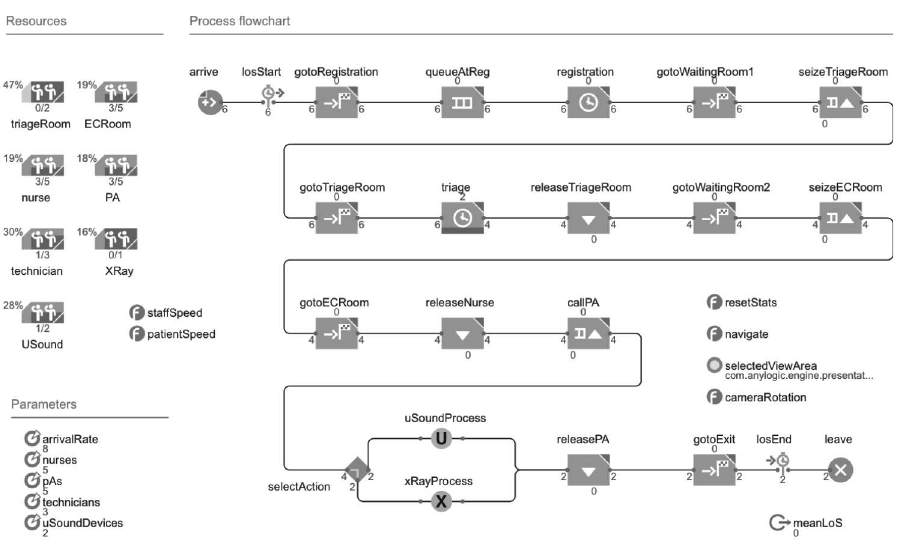
Figure 3. Emergency department discrete-event simulation model –